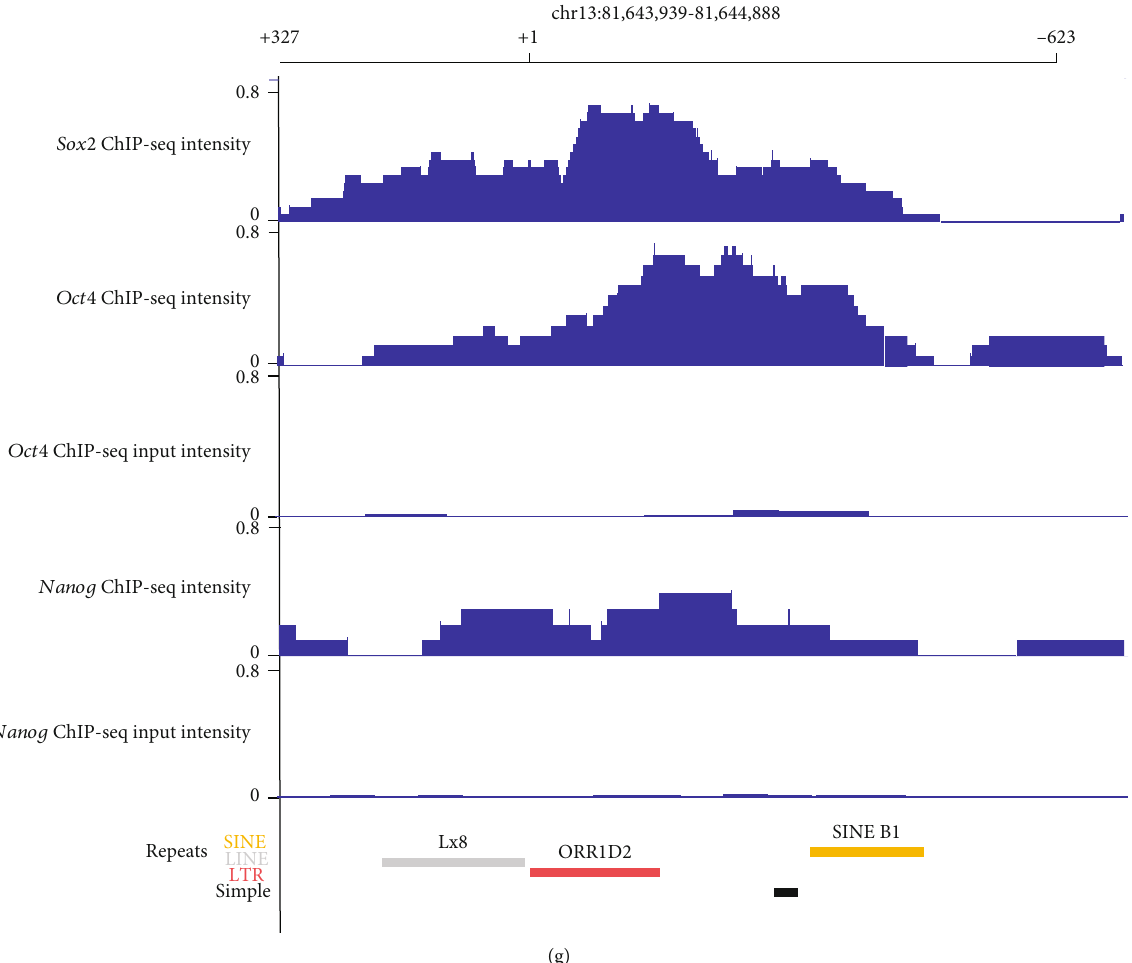
Figure 4: Oct4 and Sox2 drive the expression of lncRNA Lx8-SINE B2 . (a – c) qPCR analysis of lncRNA Lx8-SINE B2 expression after depletion of core transcription factors Oct4 (a), Sox2 (b), and Nanog (c) in ESCs. The data are represented as mean ± s : e : m : from three biological replicates. ns, non-signi fi cant; ∗∗ p < 0 : 01 ; ∗∗∗ p < 0 : 001 according to two-sided Student ’ s t -test. Biological-triplicate data ( n = 3 dishes). (d – f) Luciferase assay analysis of core promoter activity of lncRNA Lx8-SINE B2 after depletion of core transcription factors Oct4 (d), Sox2 (e), and Nanog (f) in ESCs. Biological-triplicate data ( n = 3 extracts) are presented as mean ± s : e : m . (g) Binding pro fi le of Sox2, Oct4, and Nanog on the promoter region of lncRNA Lx8-SINE B2 according to published data as described in methods. Input was included as a